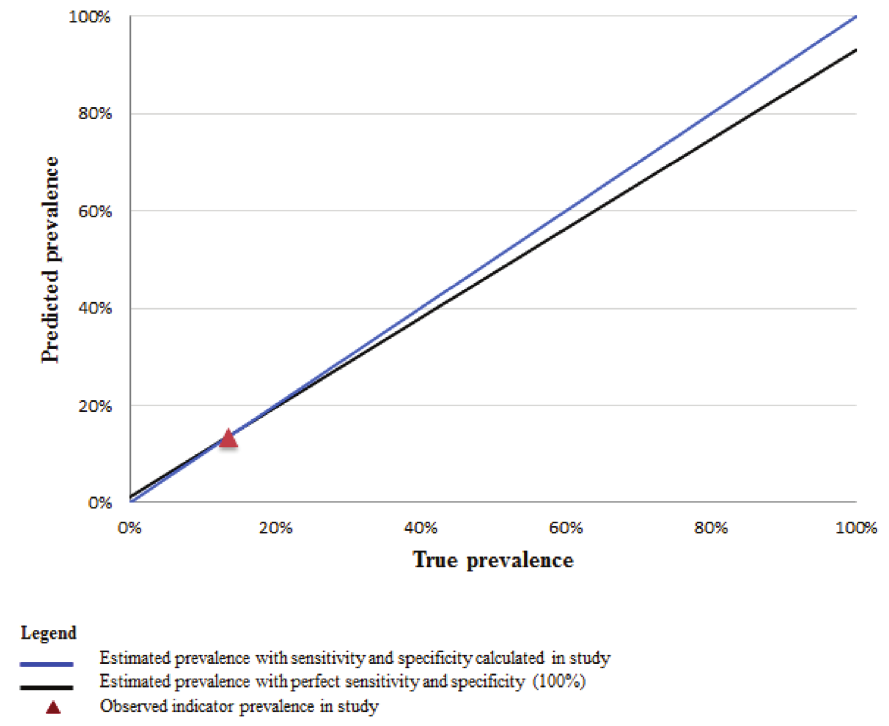
Figure 3. Predicted prevalence of caesarean operation based on sensitivity and specificity of women’s reports by true